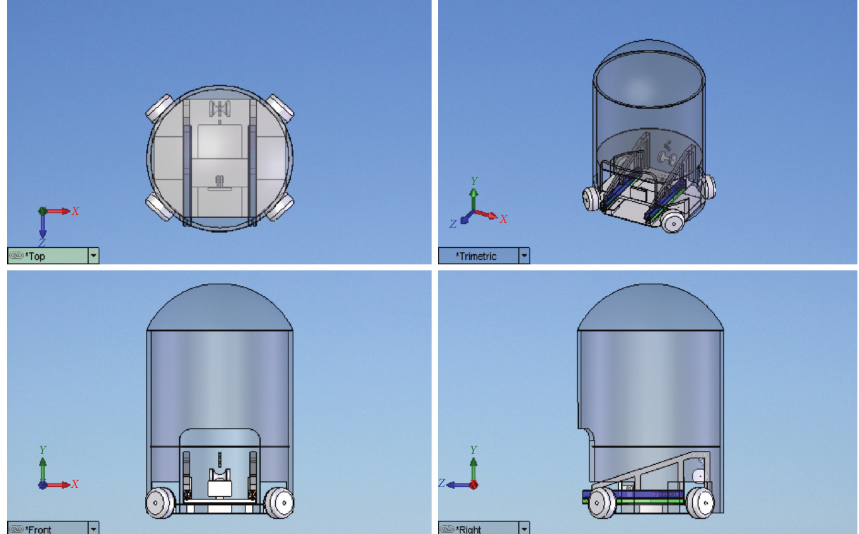
Figure 2: Conceptual design 1: Bullet design with a spring kicker.